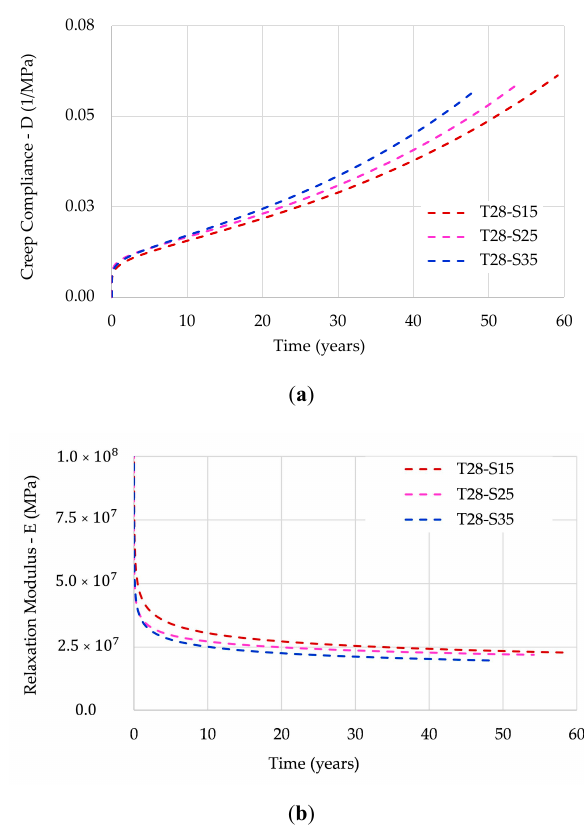
Figure 5. Full path of: ( a ) creep compliance; ( b ) relaxation modulus. Polymers 2020 , 12 , x FOR PEER REVIEW